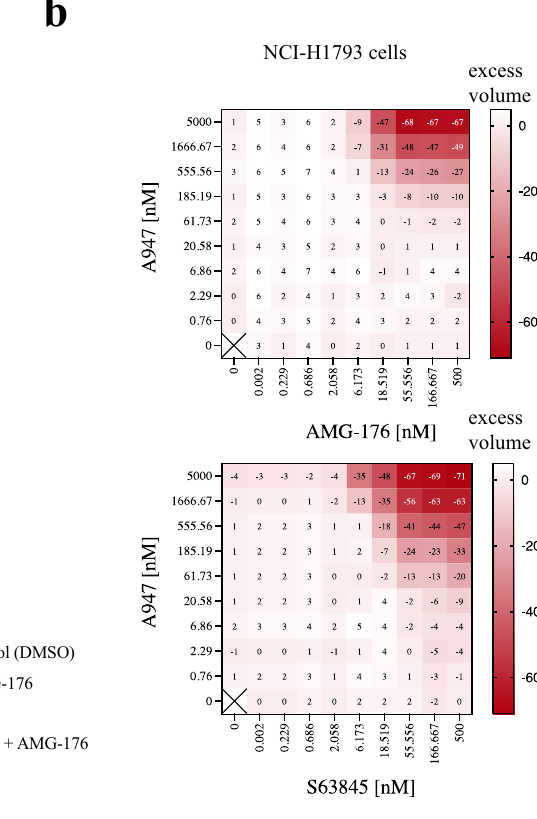
activity in excess of the Bliss independence model to describe synergistic drug interactions (excess volume). c Live cell monitoring of apoptosis in SMARCA4- mutant NCI-H1944 (left graph) and NCI-H838 (right graph) cells grown in the pre- sence of Caspase-3/7 Green Dye upon treatment with 100nM A947 and/or 1 μ M AMG-176. Data are presented apoptotic object count (mean±s.d) in triplicate cultures. Signi fi cance was calculated by a two-, unpaired t- test; p =0.0078 (NCI- H1944), p =0.0002 (NCI-H838). Source data are provided as a Source Data fi